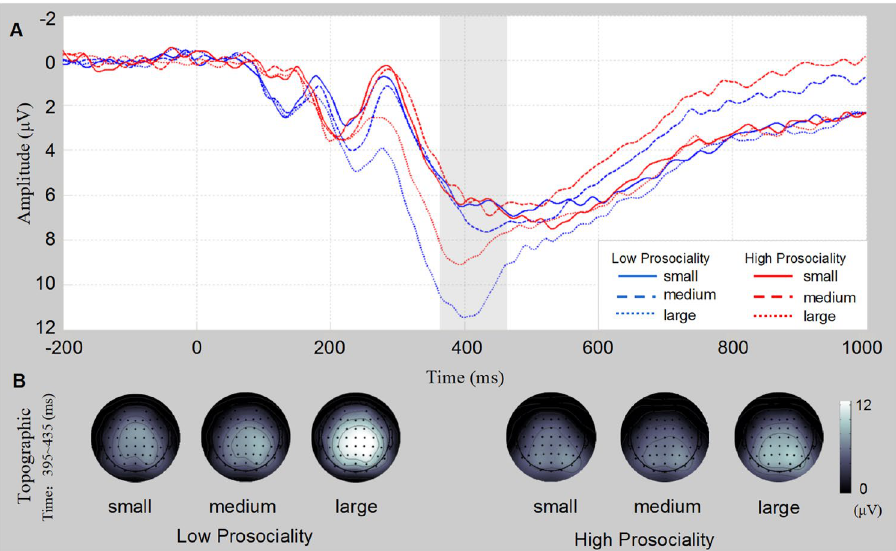
Figure 4. P300 results. ( A ) The mean waves of nine electrodes are shown. The gray area represents the selected time window. Small: the individual choose the card containing 0 star. Medium: the individual choose the card containing 1 star. Large: the individual choose the card containing 2 star. ( B ) The differential topographic map is shown.